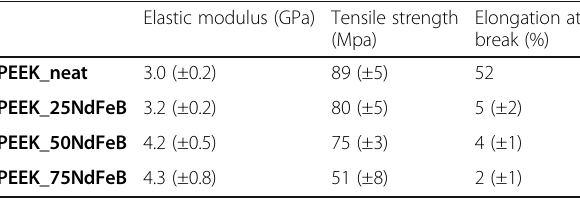
Table 7 Values of tensile strength, elastic modulus and elongation at break for all compositions (3 σ confidence